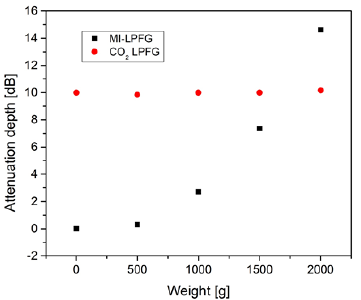
Figure 4. Attenuation depth of the main rejection bands of the MI-LPFG and the CO 2 LPFG versus applied weight on the MI-LPFG.